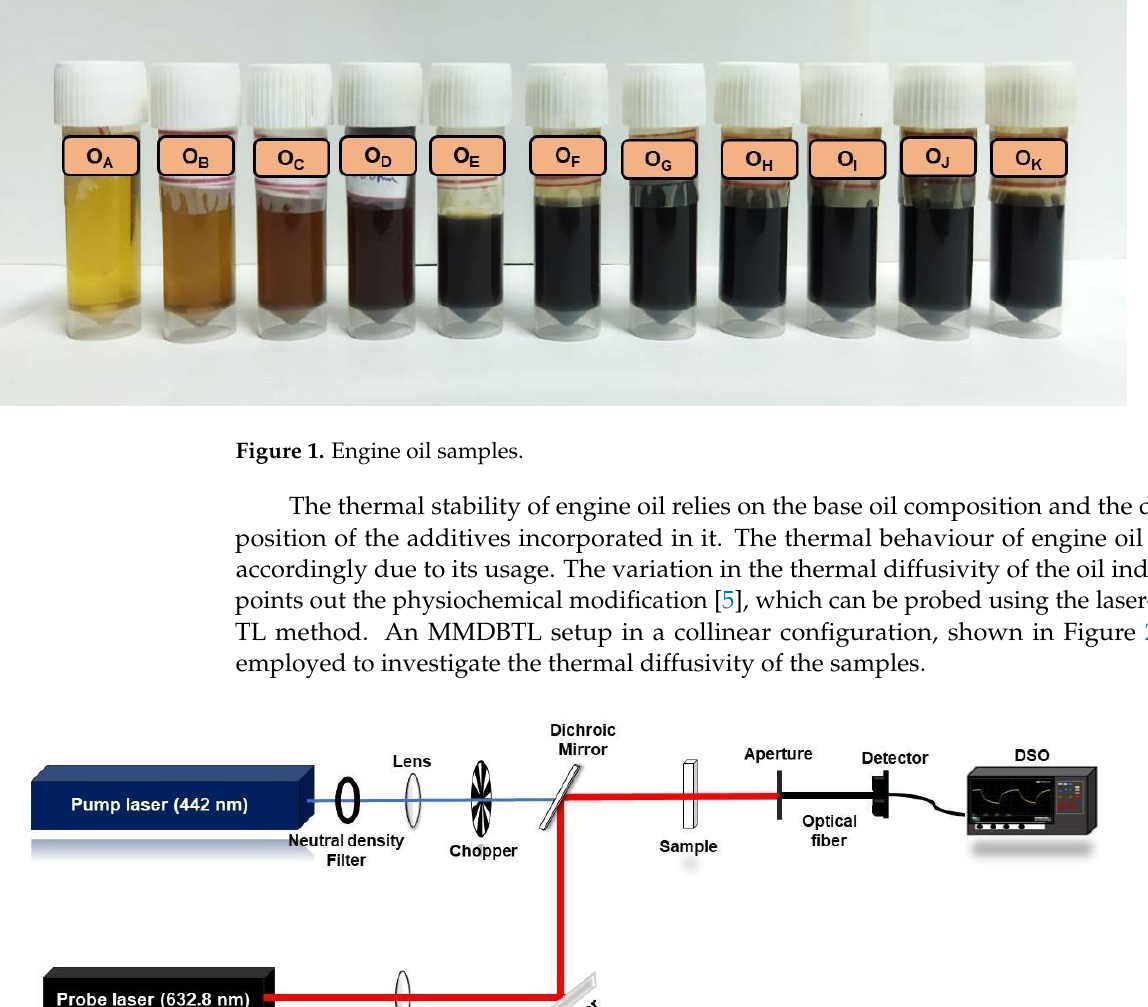
Figure 1. Engine oil samples.